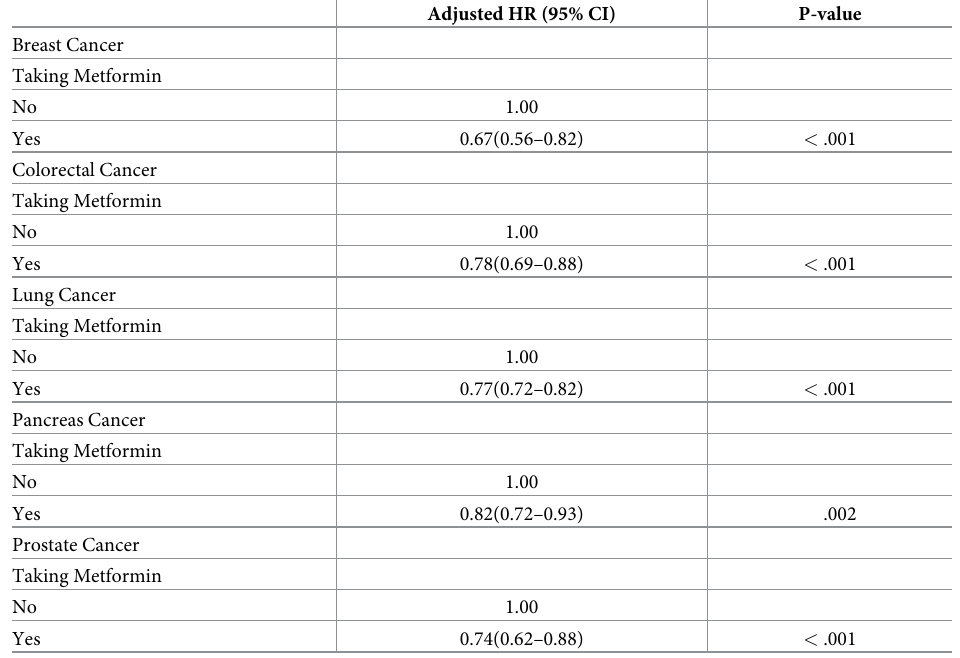
Table 3. Multivariable-adjusted hazard ratios of overall survival by Subgroup of each cancer type between patients with Metformin and those without